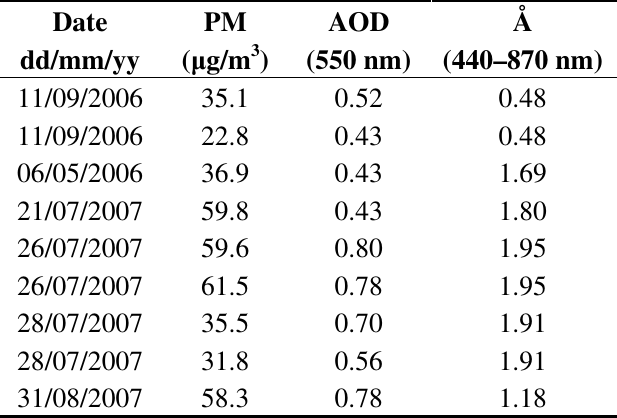
Table 6. PM mass concentration, AOT, and Angstrom coefficient (Å) values of the data points with AOT ≥ 0.4 and PM10 mass concentrations ≤ 60 µ gr/m 3